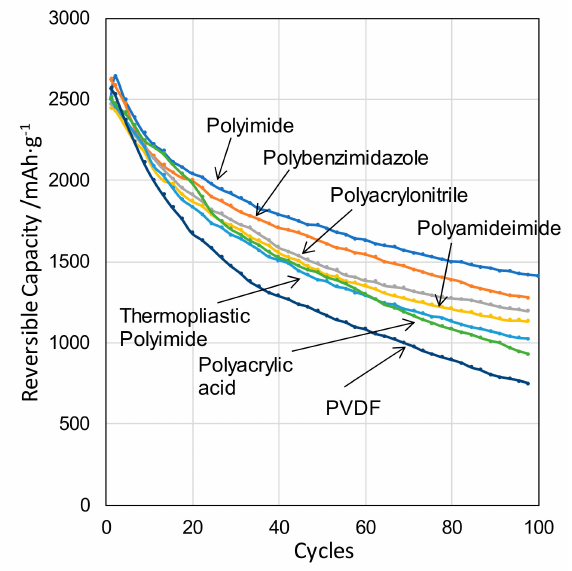
Figure 8. Dependence of binder with Si powder and conductive additive for cyclic